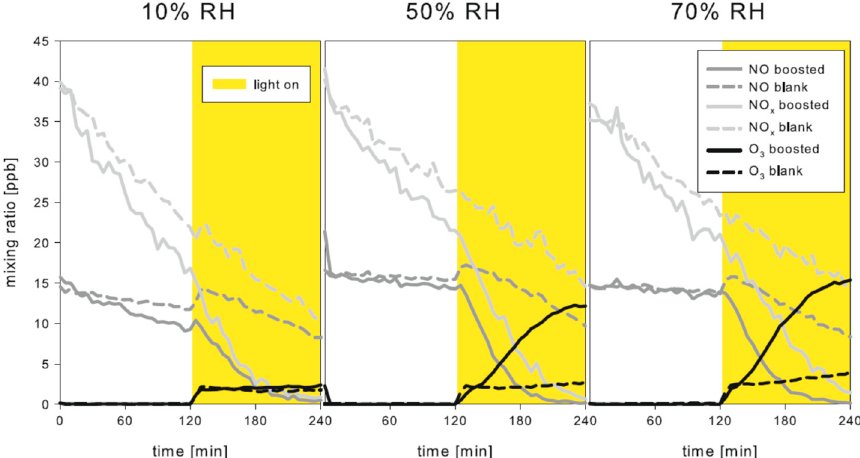
Figure 39. NO x investigations under dark and light conditions in LEAK simulation chamber (RH = 10%, 50% and 70%; T = 293 K) to compare the behavior of the boosted (solid lines) and blank materials (dashed lines) for the time-dependent changes in the concentrations of NO, NO x , and O 3 akin to environmental quantities. Reproduced with permission from Mothes et al. [25]. Copyright 2016 by Springer-Verlag Berlin Heidelberg (License No.: 4453250415918).